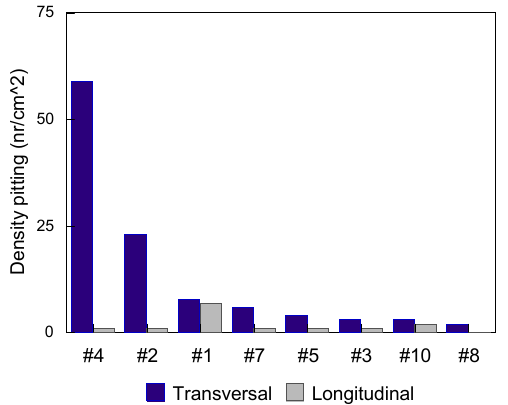
Figure 7. Pitting test results of the transverse and longitudinal surfaces for various grades of steels (0.1 M FeCl 3 test medium at 37 °C for 15 days).